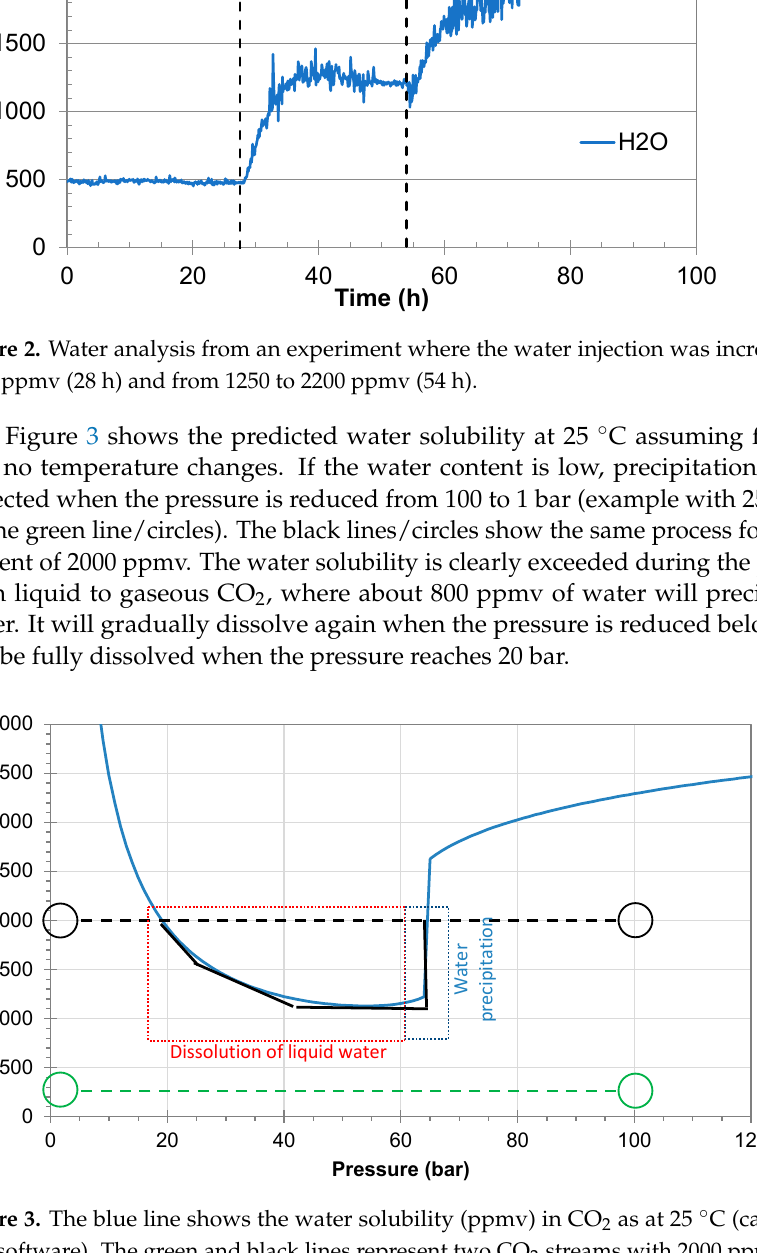
Figure 3. The blue line shows the water solubility (ppmv) in CO 2 as at 25 °C (calculated with the OLI software). The green and black lines represent two CO 2 streams with 2000 ppmv and 250 ppmv water, respectively.